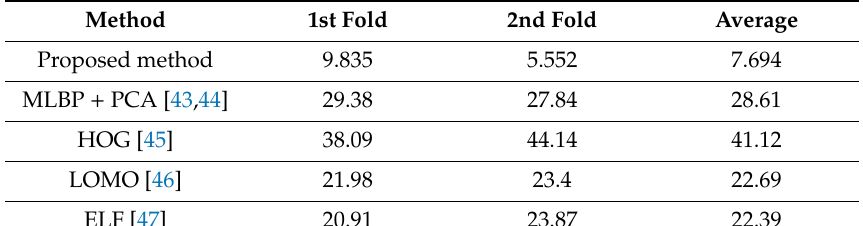
Table 9. Comparison of EER for the results of the proposed and previous face and body recognition methods (unit: %).